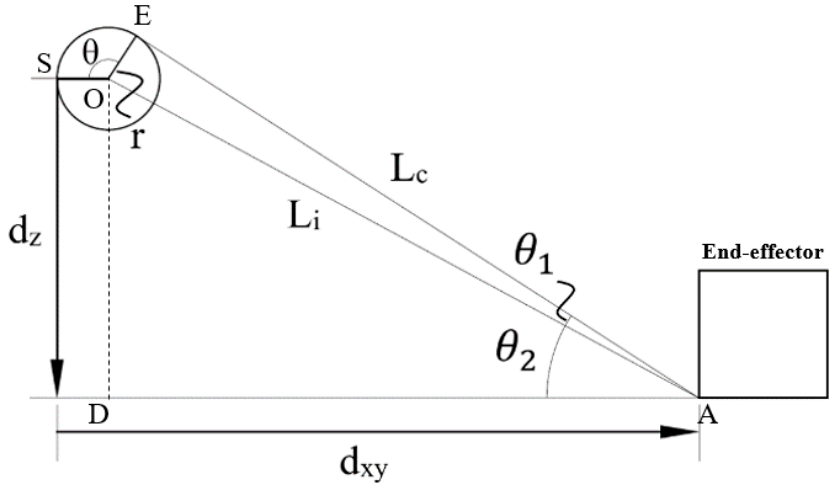
Figure 3. Diagrammatic representation of the pulley kinematics.